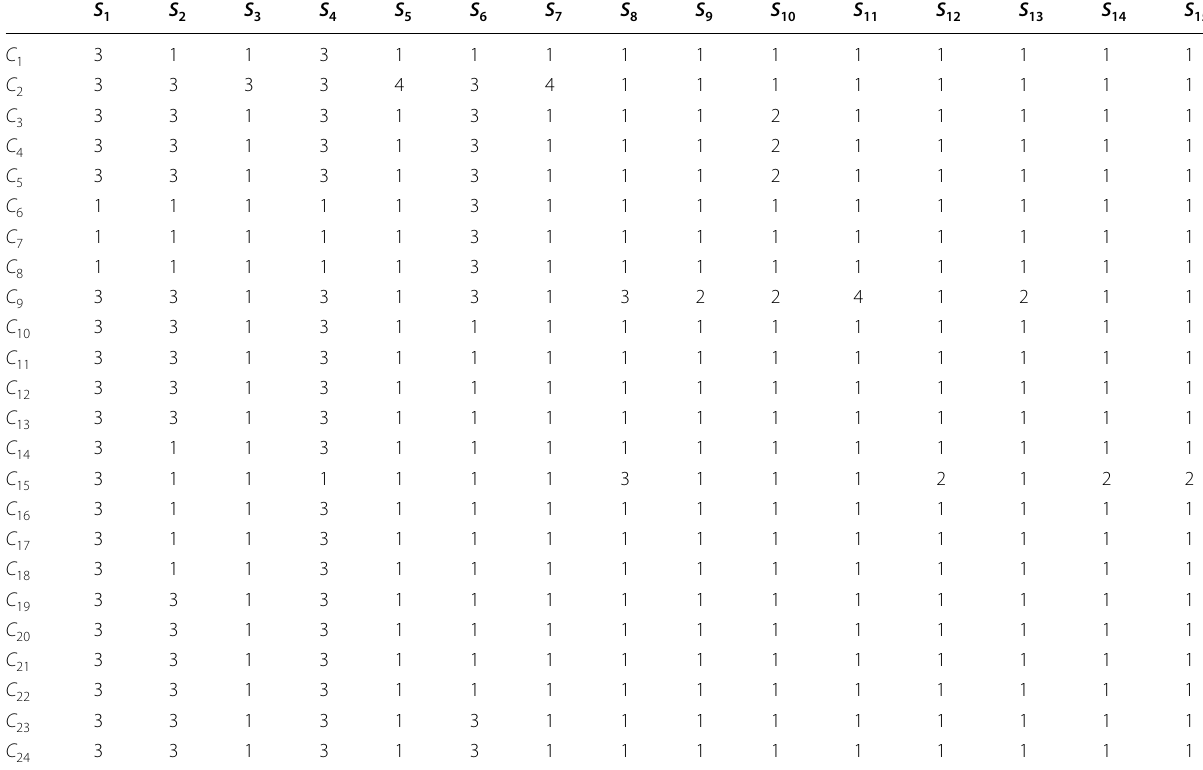
Table 6 Specifications-components relation